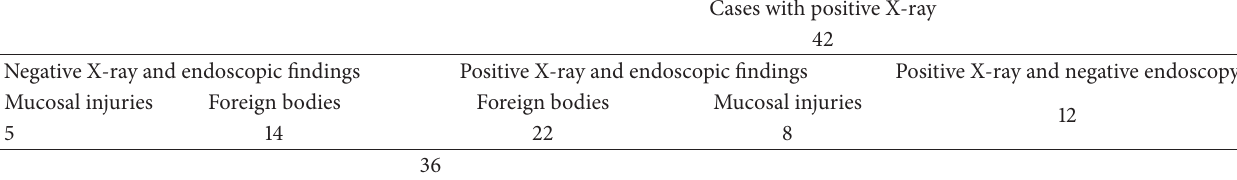
Table 4: Correlations between X-ray and endoscopic